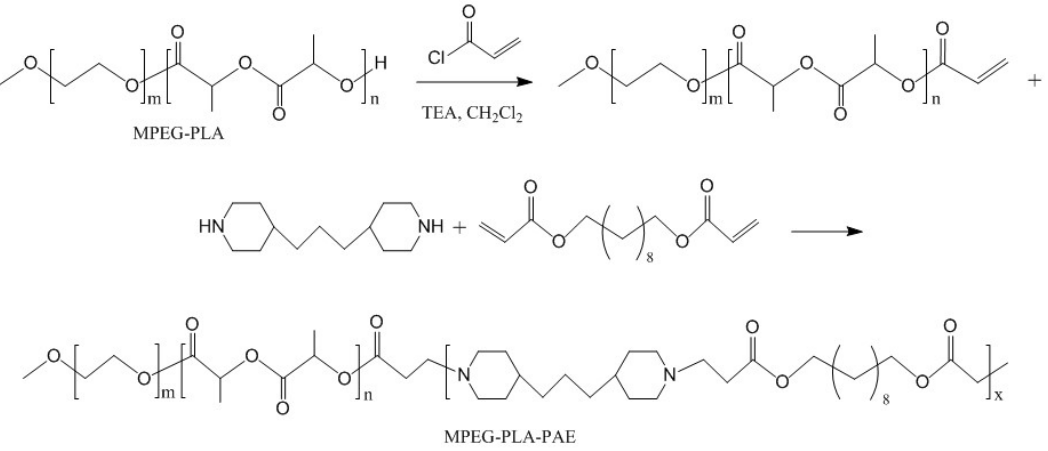
Figure 1. Synthesis scheme of MPEG ‐ PLA ‐ PAE.